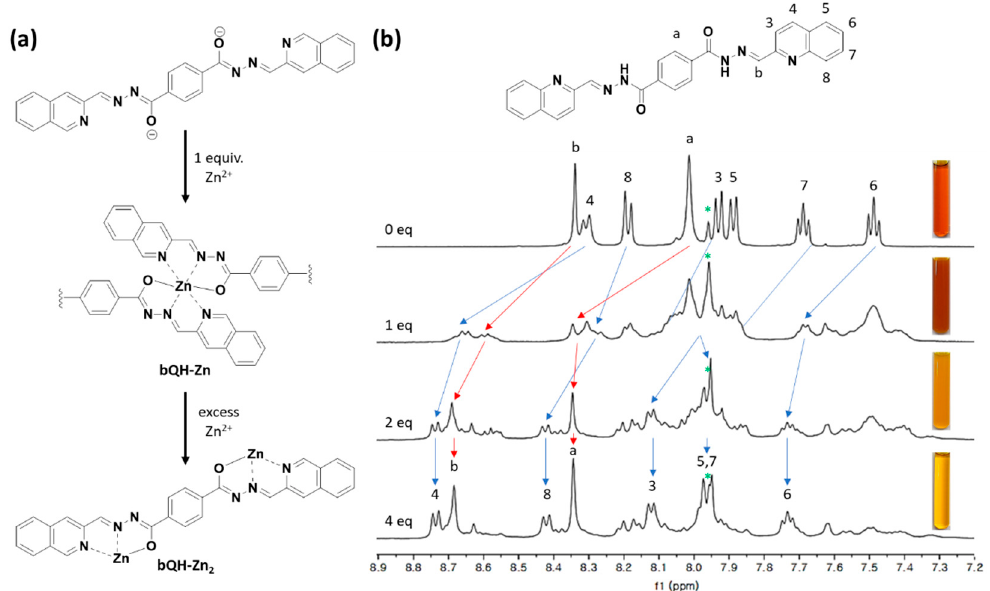
Figure 4. ( a ) Schematic representation of changes in deprotonated bQH followed by addition of the Zn 2 + ion. ( b ) Partial 1 H-NMR (500 MHz) of bQH (2.0 × 10 − 2 M) in DMSO- d 6 with 2 equivalents of tetraethylammonium hydroxide, by adding up to 4 equivalents of Zn(ClO 4 ) 2 . The * (in green) indicates the solvent peak.